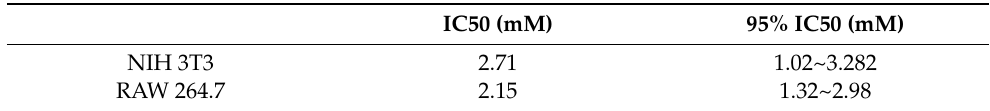
Table 1. Mean inhibitory concentrations (IC50) of metformin in NIH 3T3 and RAW 264.7 cell lines ( n = 3; means and confidence intervals